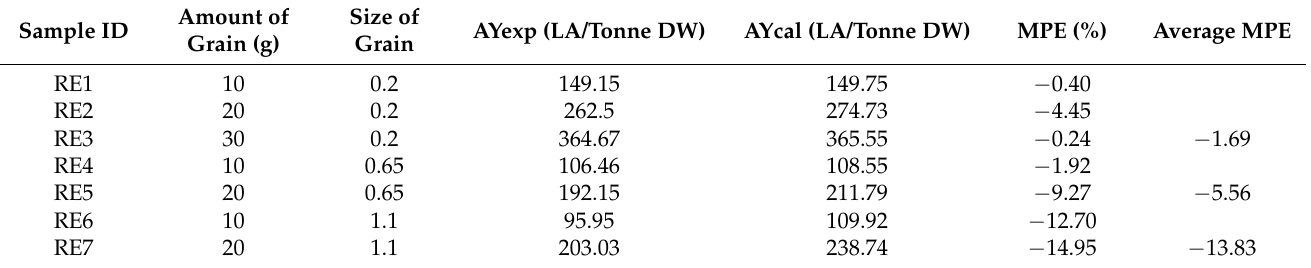
Table 2. Regression equation experimental plan based on grain amount and size (Section 2.5), the average experimental alcohol yield (AY exp ) achieved during experimental trial and the predicted alcohol yield (AY cal ) from the regression equation and the MPE used to check the accuracy of the regression